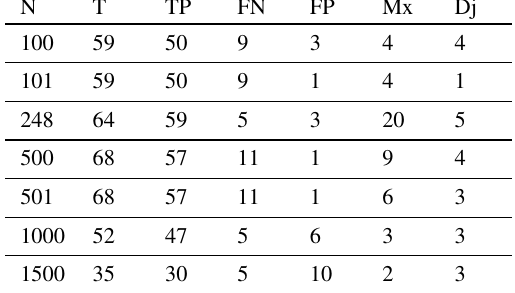
Table 2: Identification results for very congested traffic. The la- bels are as identified in Table 1.